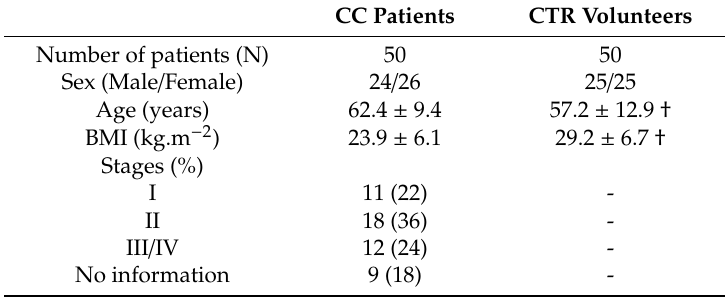
Table 1. Demographic and clinicopathologic characteristics of colon cancer (CC) patients and control (CTR)